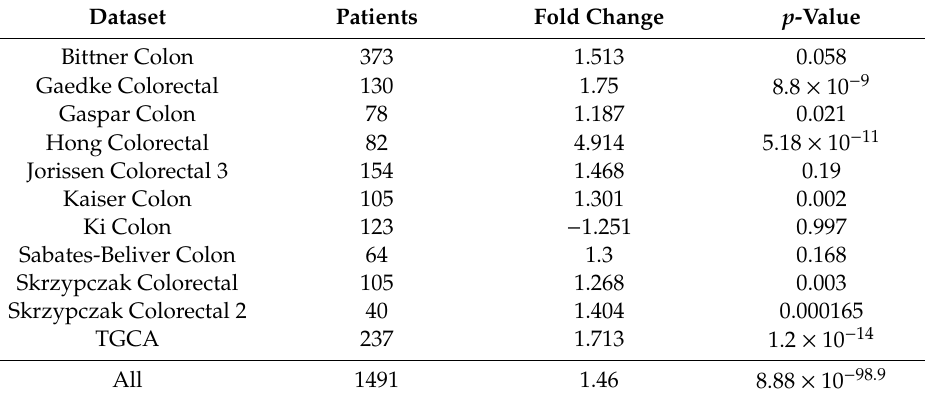
Table 1. WNT11 mRNA expression in CRC datasets 1